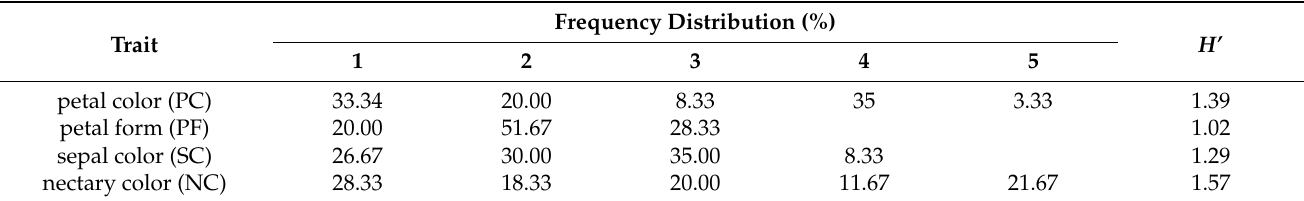
Table 3. Frequency distribution and diversity of quality traits in flower organs of L. chinense var. rubrum